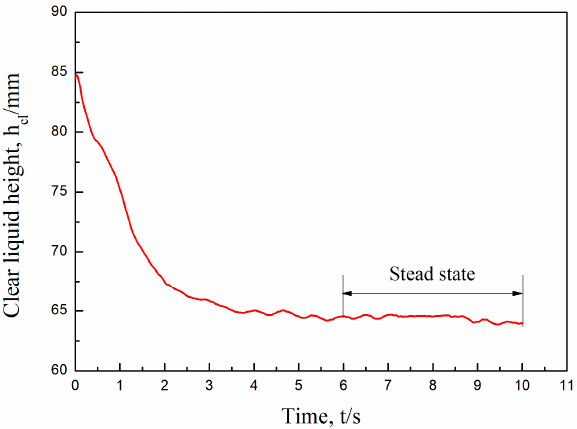
Figure 4. Transient clear liquid height monitored as a function of time. U S = 0.65 m/s, h W = 0.054 m, Q L /L w = 20 m 3 /(m·h).